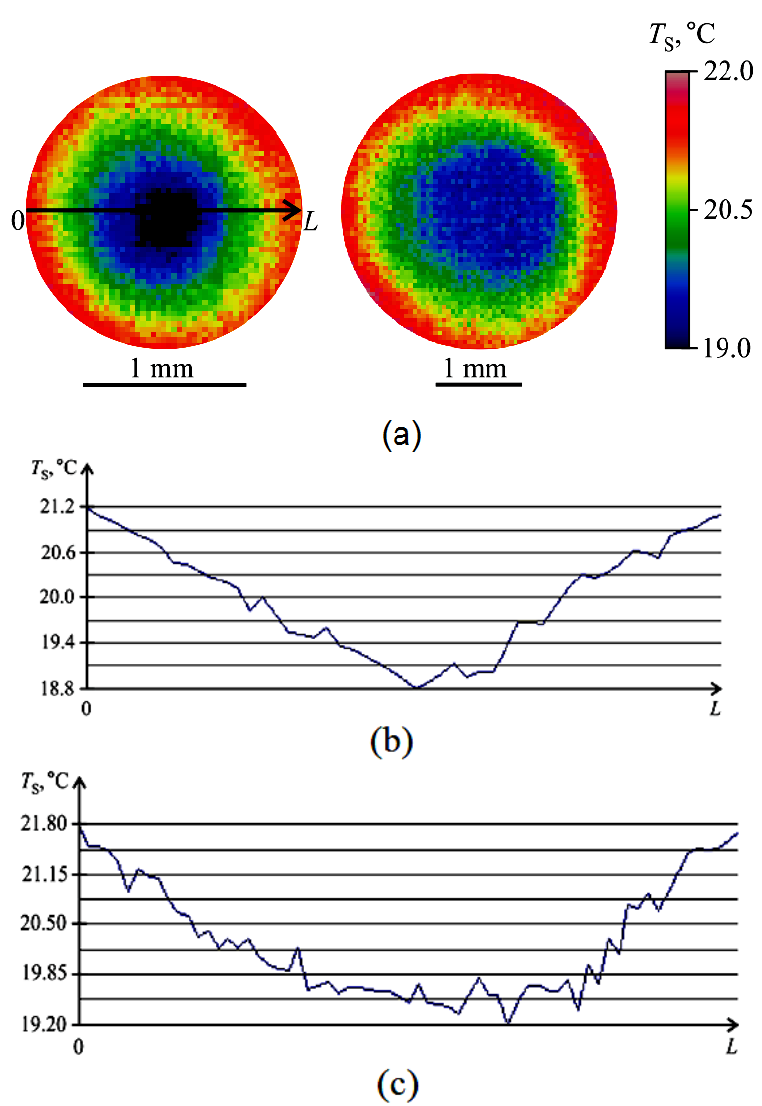
Figure 10. ( a ) Thermal images of the droplet interface for t = 20 s (without heating): water is on the left; water with surfactant (10,000 ppm) is on the right; and temperature profiles of the droplet interface at a cross section of 0 L : ( b ) water; ( c )-water with surfactant (10,000 ppm). With high temperature heating ( T w = 90 ◦ C), the droplet diameter increases by 50–60% due to the addition of surfactant. Due to the fast evaporation rate on the heated wall, the temperature T s depends much more on the drop height. For a water with surfactant droplet, the average temperature T s (Figures 11 and 12 for t = 7 s) for the droplet surface is 4–5 ◦ C higher than that for water during almost the entire evaporation time. This effect of nonisothermality ( J T ) leads to a 14–17% increase in the evaporation rate of a droplet of water with surfactant, compared to a pure water drop (according to the water vapor equilibrium curve). Figures 11 and 12 show thermal images of the surface of a drop located on a heated wall, as well as temperature distributions of T s along the 0 L axis. As the wall temperature and T s increase, the difference ∆ T s increases (comparison with Figure 10a). The small height of the drop and the high heat flux from the wall contribute to the temperature field uniformity over the drop